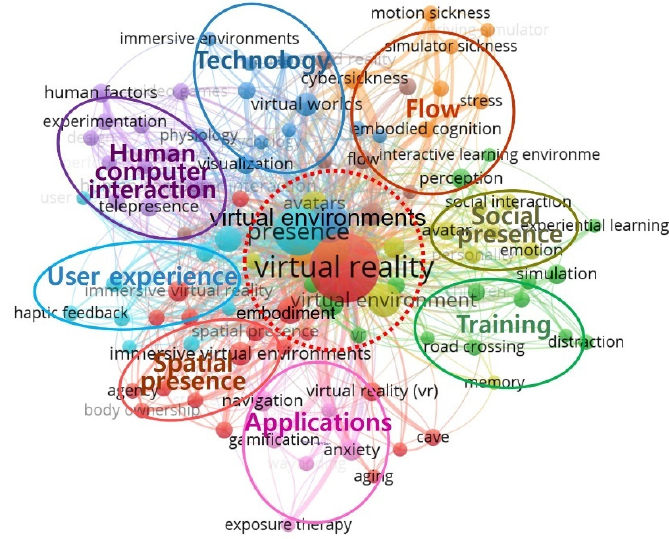
Figure 15. The mind map of embodied experience in VEs drawn from the findings of performance analysis (Source: Authors).